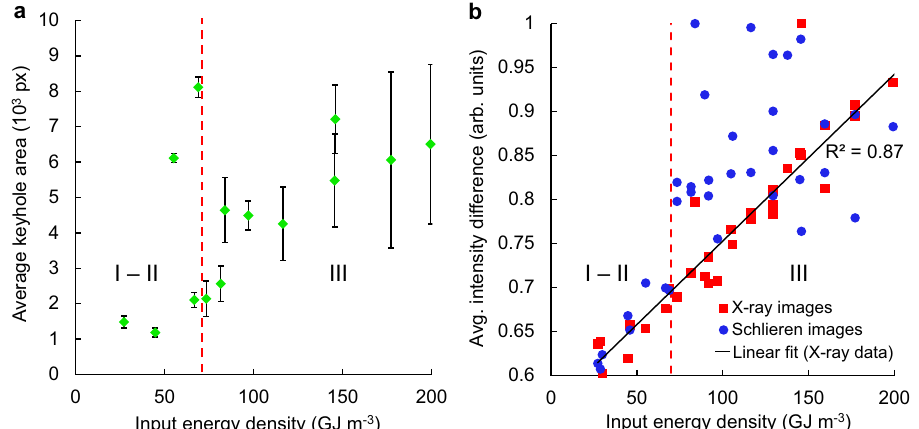
Fig. 5 Measurements of melt pool/plume stability under varying input energy density. a Plot of keyhole area (error bars: standard deviation ± σ ), showing the melt pool becomes increasingly unsteady as the input energy density increases. b Average intensity difference between consecutive frames. The red dotted line indicates a step increase in average intensity difference for the schlieren images at E = ~70 GJ m − 3 that marks the transition from stable to chaotic plumes, and thus, depression instability.